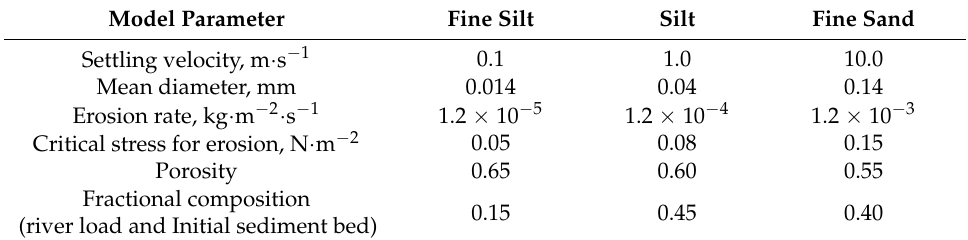
Table 3. Sediment properties and model input